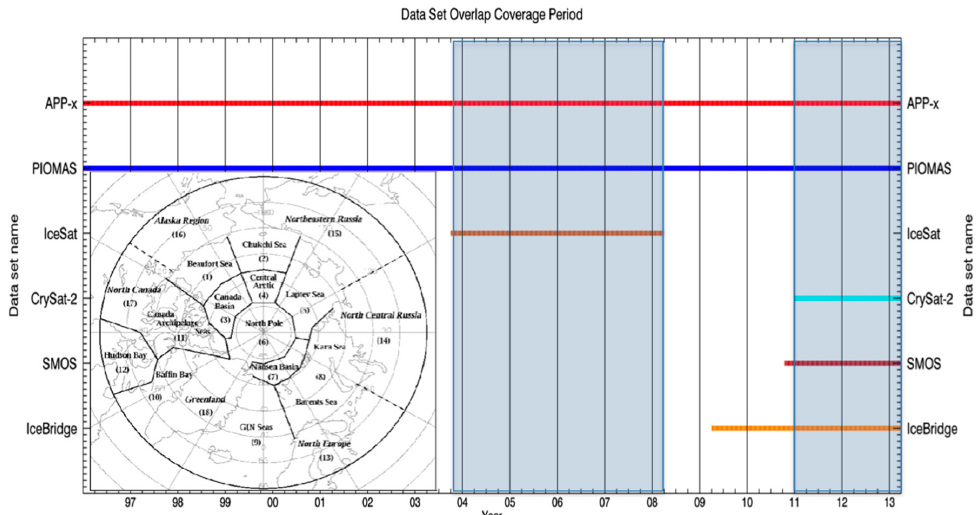
Figure 1. The time coverage of the six sea ice thickness datasets as used in this study. All but ICESat continue to the present day. The dataset overlap periods are shaded. An Arctic map with analysis regions is also shown.